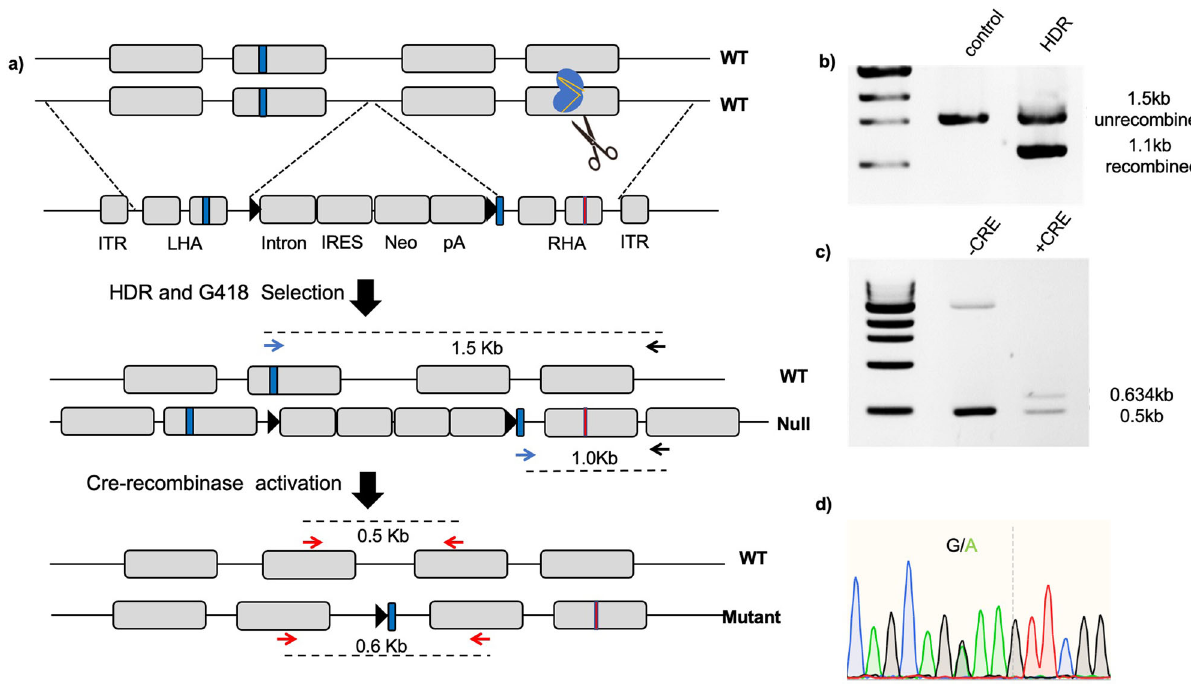
Fig. 2 Schematic overview of single-allele editing of SF3B1 locus using CRISPR/Cas9 and rAAV. a Schematic of “ In – Out ” PCR screening strategy of clones after single-allele recombination before Cre activation (screening primer pair denoted as black and blue arrows) and after Cre activation (denoted as red arrows) is shown. b PCR analysis of genomic DNA isolated from unedited and edited K562 cells that underwent recombination (using screening primer pair from the middle panel of a ). c PCR analysis of genomic DNA from edited K562 cells post Cre activation (using screening primer pair from the lower panel of a ). d Con fi rmation of successful single-allele K700E mutation by Sanger sequencing of genomic